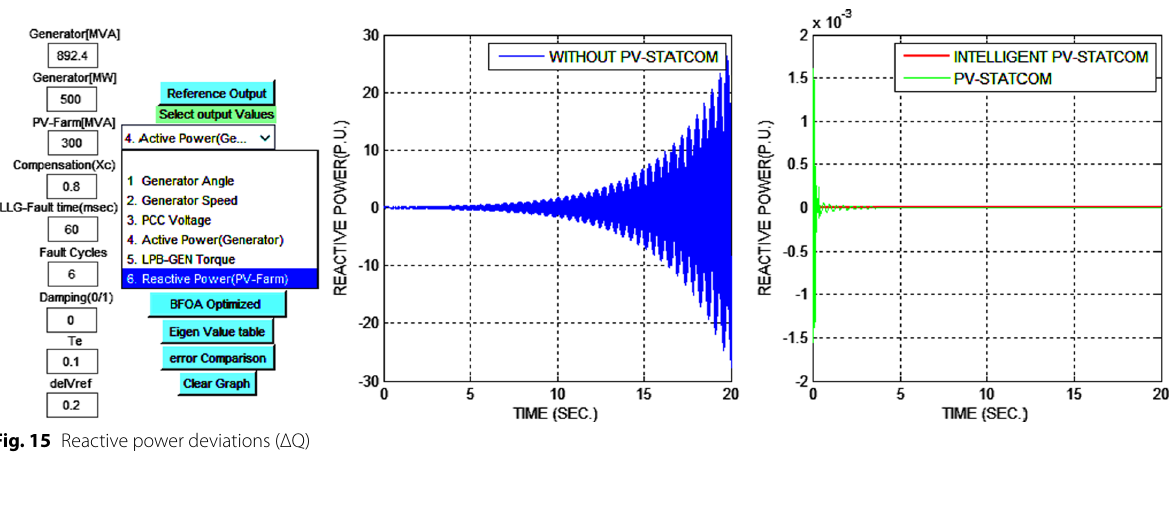
Fig. 14 Torsional deviations ( �τ Lp